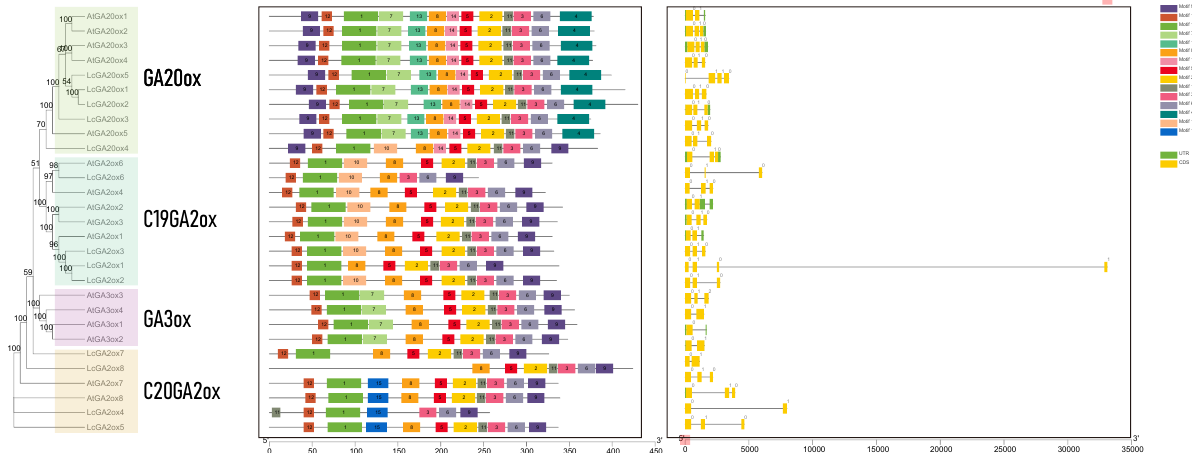
Figure 2. Evolutionary relationships, conserved protein motifs and gene structure in GAox genes from L. chinense and A. thaliana . The phylogenetic tree was constructed using the neighbor joining (NJ) method with 1000 bootstrap replicates in MEGA 7.0. All protein sequences of gibberellin oxidase in L. chinense and A. thaliana were divided to four subgroups. Different colors represent different subgroup. The numbers 1–15 of motif composition was displayed in different colored boxes in LcGAox and AtGAox proteins. Gene structure was showed off in the right box, the yellow box represents the coding sequences and the green box represent the UTR